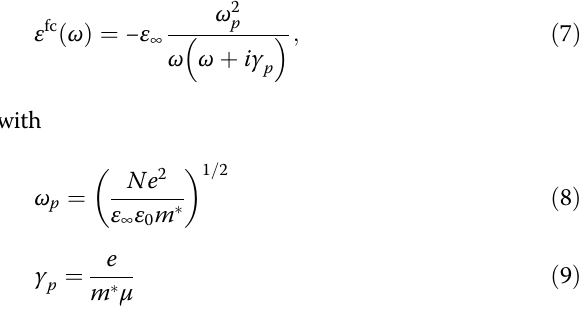
on the free carrier concentration N , high-frequency dielectric permittivity ε ∞ , and the effective mass m of the electrical unity charge). The plasmon damping parameter γ p depends on the optical carrier mobility μ (Eq. (9)) [24]. Parameters of ω and LOPC modes can be determined LO from the imaginary part of the energy loss function — Im [7], where ε ( ω ) is the complex dielectric function, obtained from Eq.